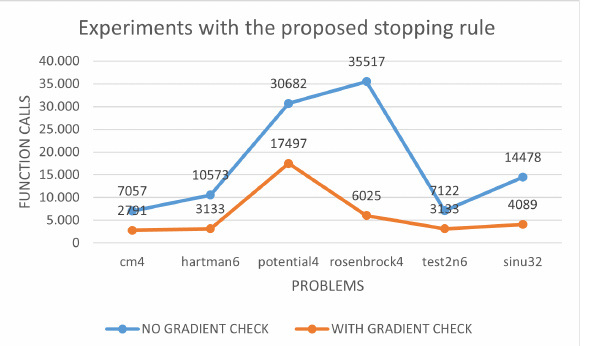
Figure 4. Experiments with the proposed stopping rule with the gradient check and without the gradient